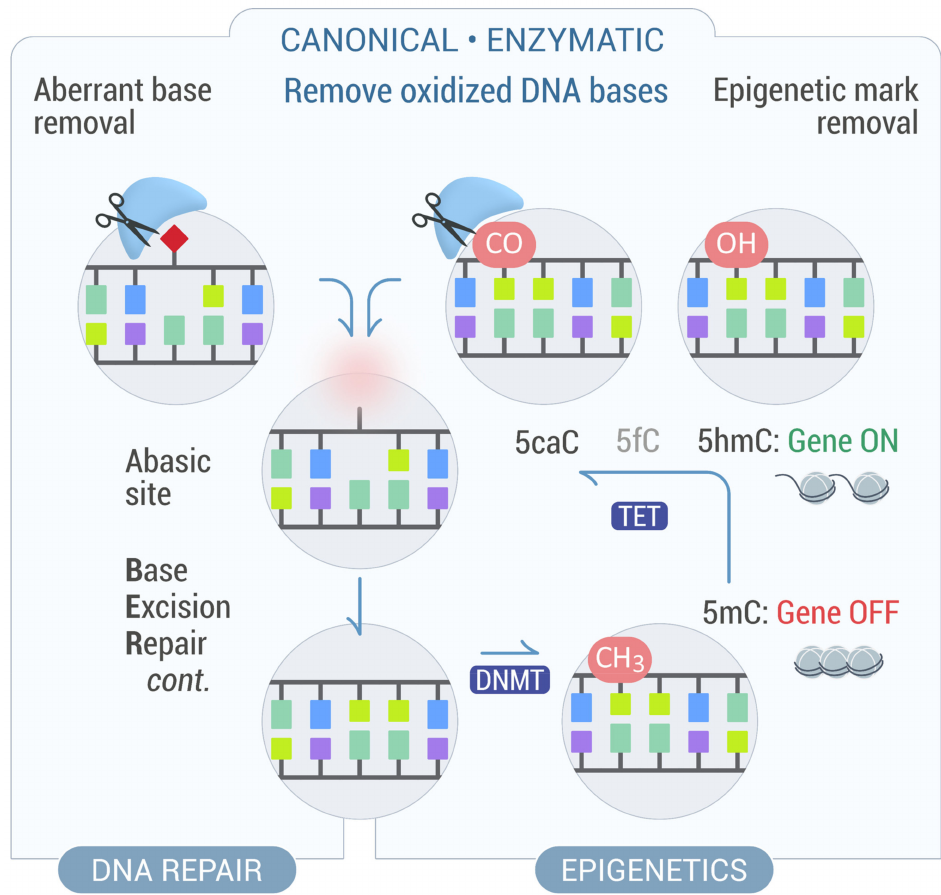
Figure 2. Canonical and non-canonical roles of DNA glycosylases in the removal of oxidative DNA- base modifications. DNA glycosylases can both remove oxidative base lesions from DNA, thus triggering BER, and remove specific epigenetic marks, thereby influencing gene